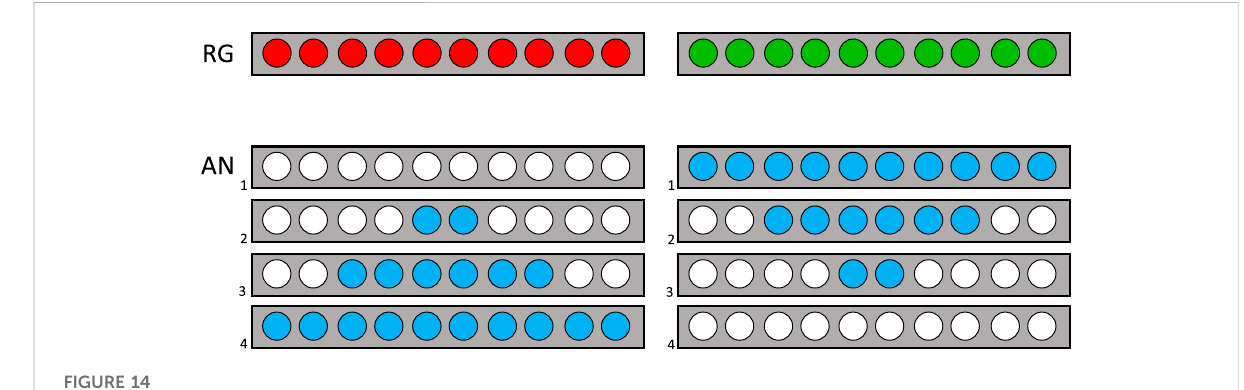
FIGURE 14 Overview of the two conditions Red-Green (RG) and Animation (AN).